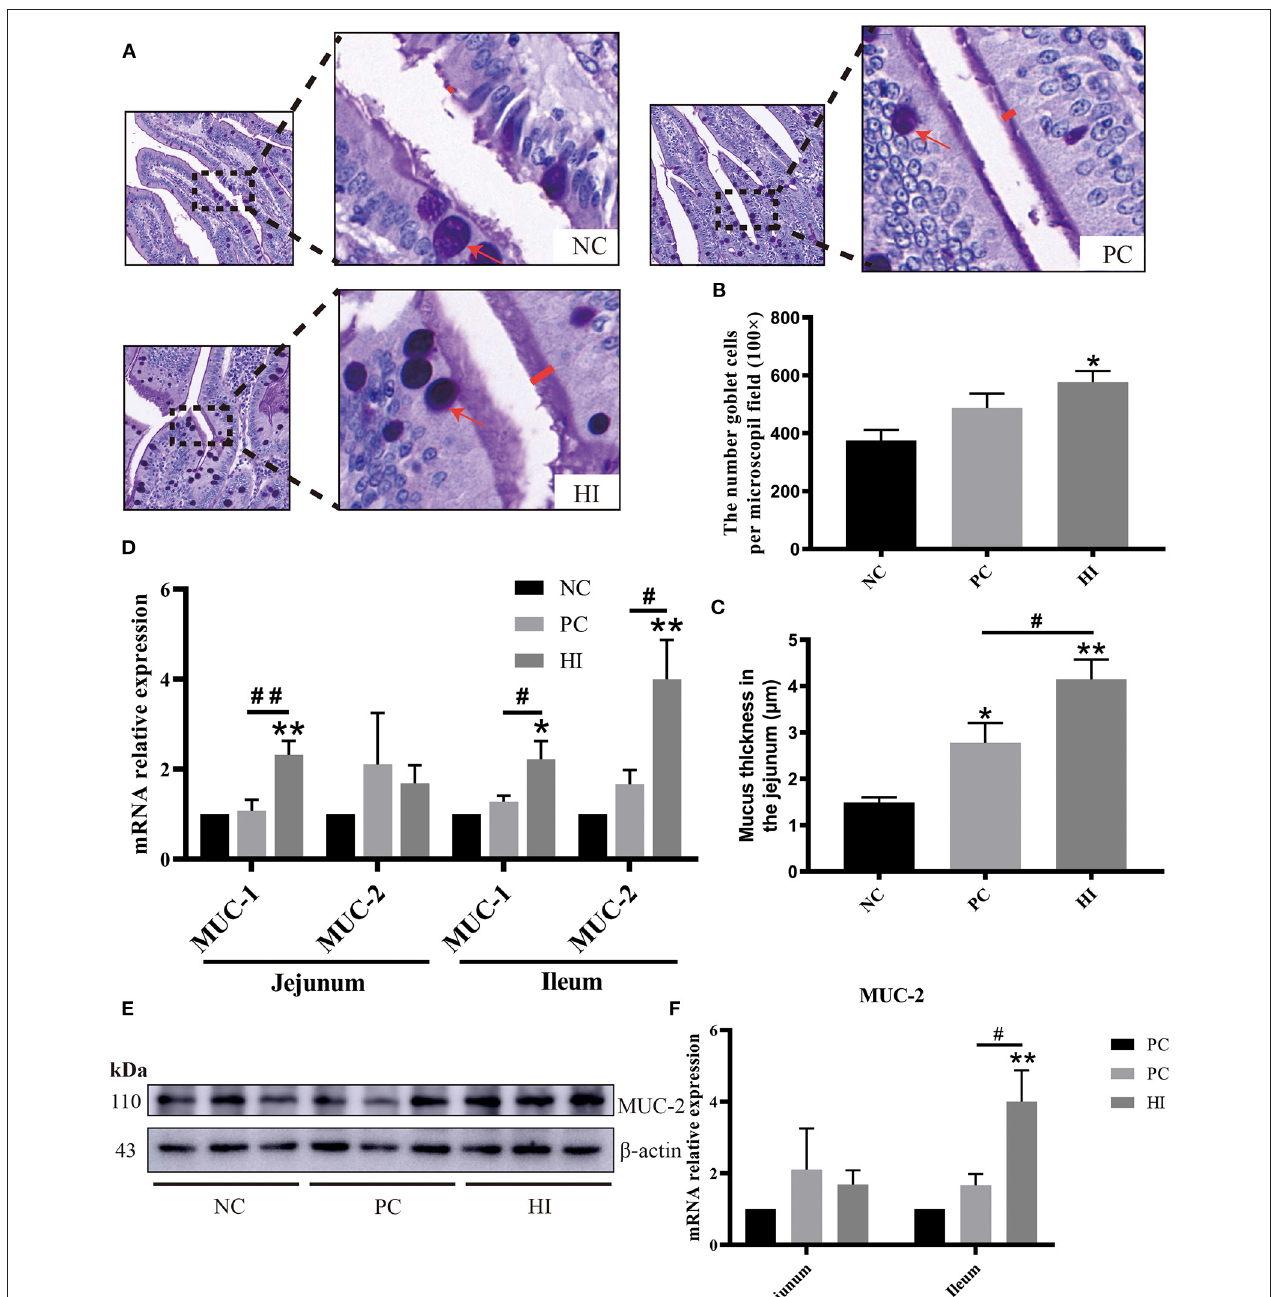
FIGURE 2 | Effect of dietary Hermetia illucens larvae on mucin secretion in weaned pigs. (A) Representative images of jejunal PAS stains. The number of goblet cells (B) per microscopic field (original magnification × 100) and mucus layer thickness (C) in the jejunum of weaned pigs were determined. (D) Real-time quantitative PCR was performed to determine the relative mRNA expression levels of MUC-1 and MUC-2 in the jejunum and ileum. (E) Relative protein expression of MUC-2 in the ileum determined using western blot. Densitometric values were normalized to those of β -actin. (F) Statistical analysis of the data in E. All data are expressed as the mean ± SEM (protein expression data n = 3, other data n = 6). * p < 0.05, ** p < 0.01 compared with NC, # p < 0.05, ## p < 0.01 HI compared with PC.